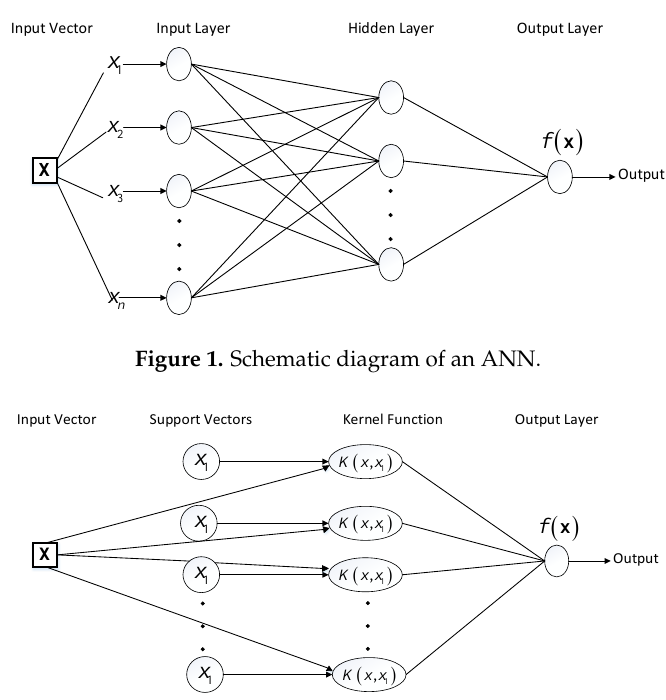
Figure 2. Schematic diagram of a SVM.